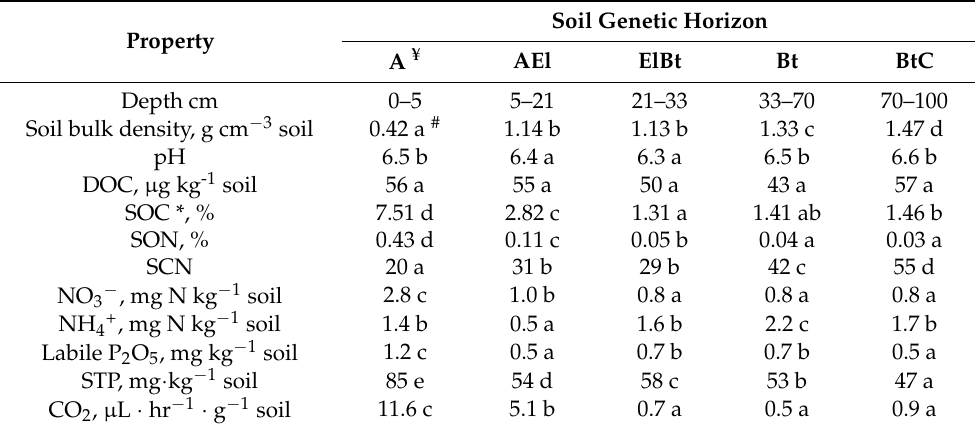
Table 1. Properties of soil genetic horizons of the undisturbed Phaeozem under birch forest in West Siberia